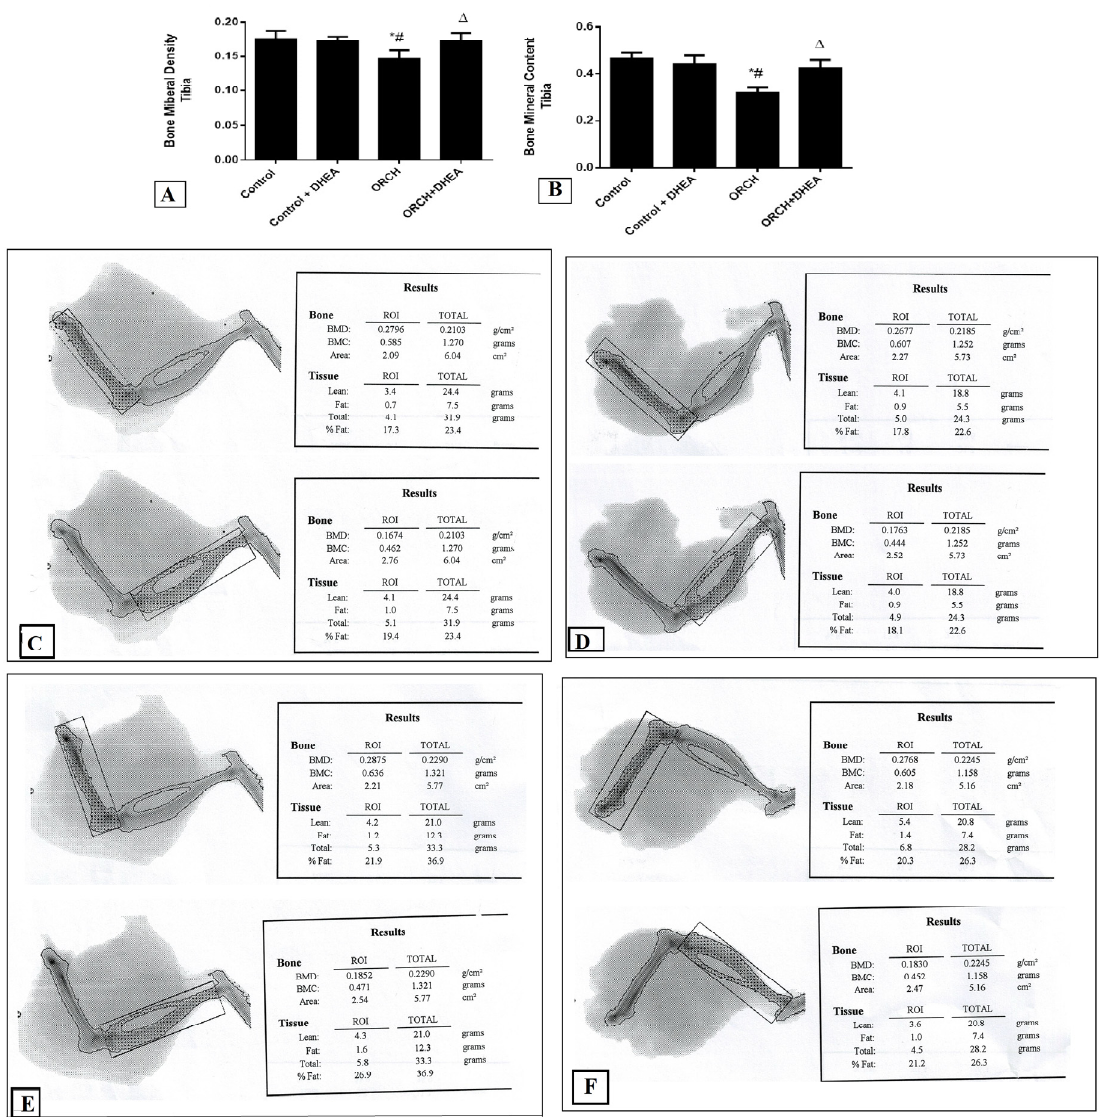
Figure 2. Effect of orchidectomy and DHEA treatment on ( A ) bone mineral density (BMD) and ( B ) bone mineral content (BMC) of the tibia. Representative samples of BMC and BMD from ( C ) control group, ( D ) control + DHEA, ( E ) ORCH and ( F ) ORCH + DHEA groups. Data were expressed as mean ± SD of 8 rats. *: p < 0.05 versus control, #: p < 0.05 versus control + DHEA, ∆ : p < 0.05 versus ORCH.